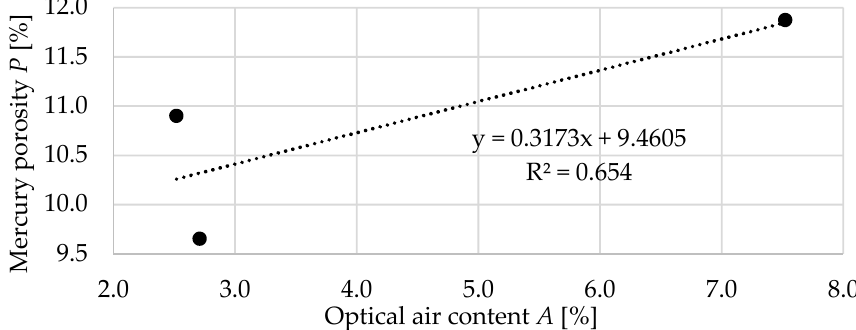
Figure 16. The relation between the optical air content A and mercury intrusion total porosity P.